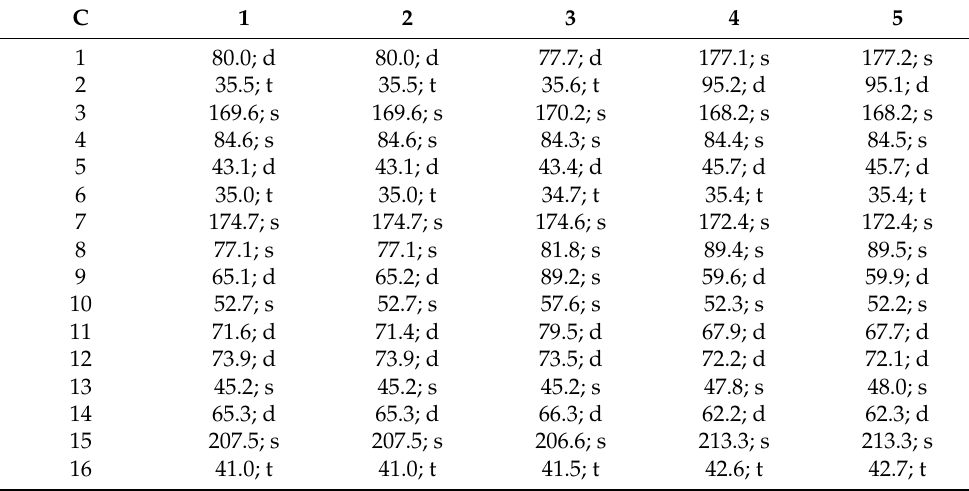
Table 2. 13 C NMR spectroscopic data for 1 – 5 recorded in CDCl 3 . The chemical shifts are in ppm, the multiplicities were determined by HMQC experiments. The solvent signal at 77.0 ppm was used as